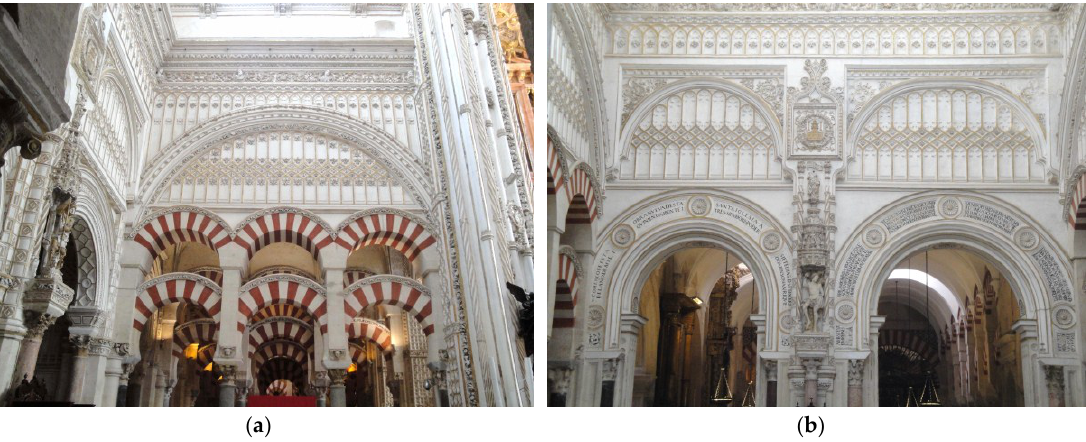
Figure 2. Hernan Ruiz I. Transept. Mosque-Cathedral (Cordoba): ( a ) East side; ( b ) South side. Photos took by author.